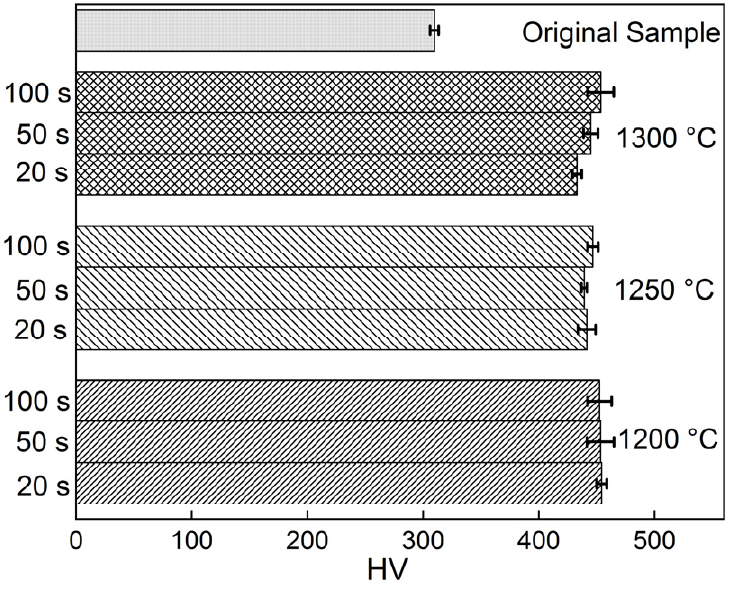
Figure 13. EBSD analysis using inverse pole figure maps: ( a ) 1300 °C, t 8/5 = 20 s; ( b ) 1250 °C, t 8/5 = 20 s; ( c ) 1200 °C, t 8/5 = 20 s.